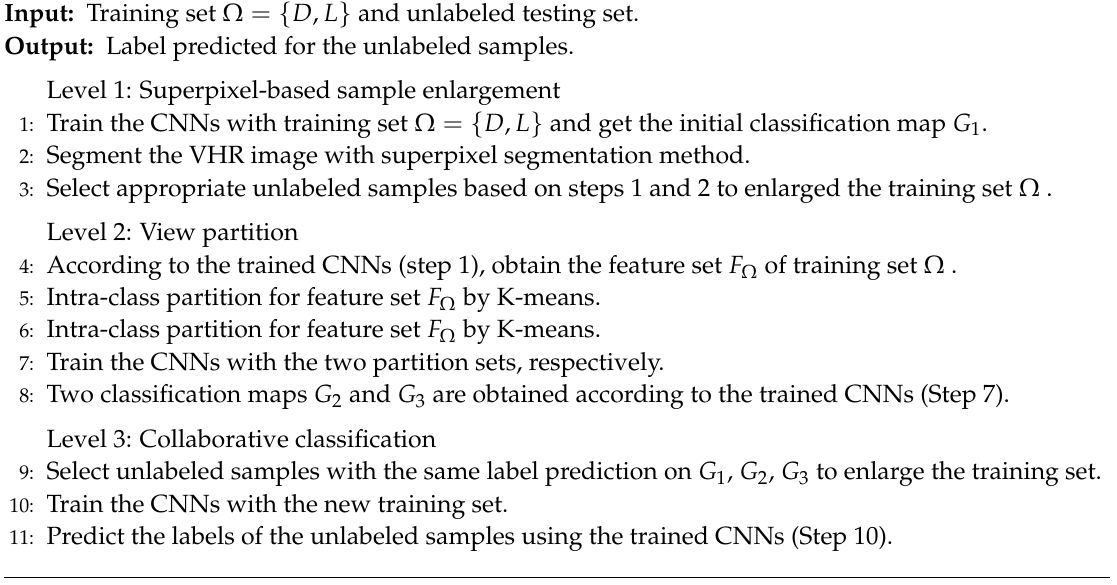
Figure 6. Construction of the final training set based on the samples selected in the previous stages. The green markers are the positions of the selected training samples. Algorithm 1 Hierarchical multi-view semi-supervised learning for VHR remote sensing image